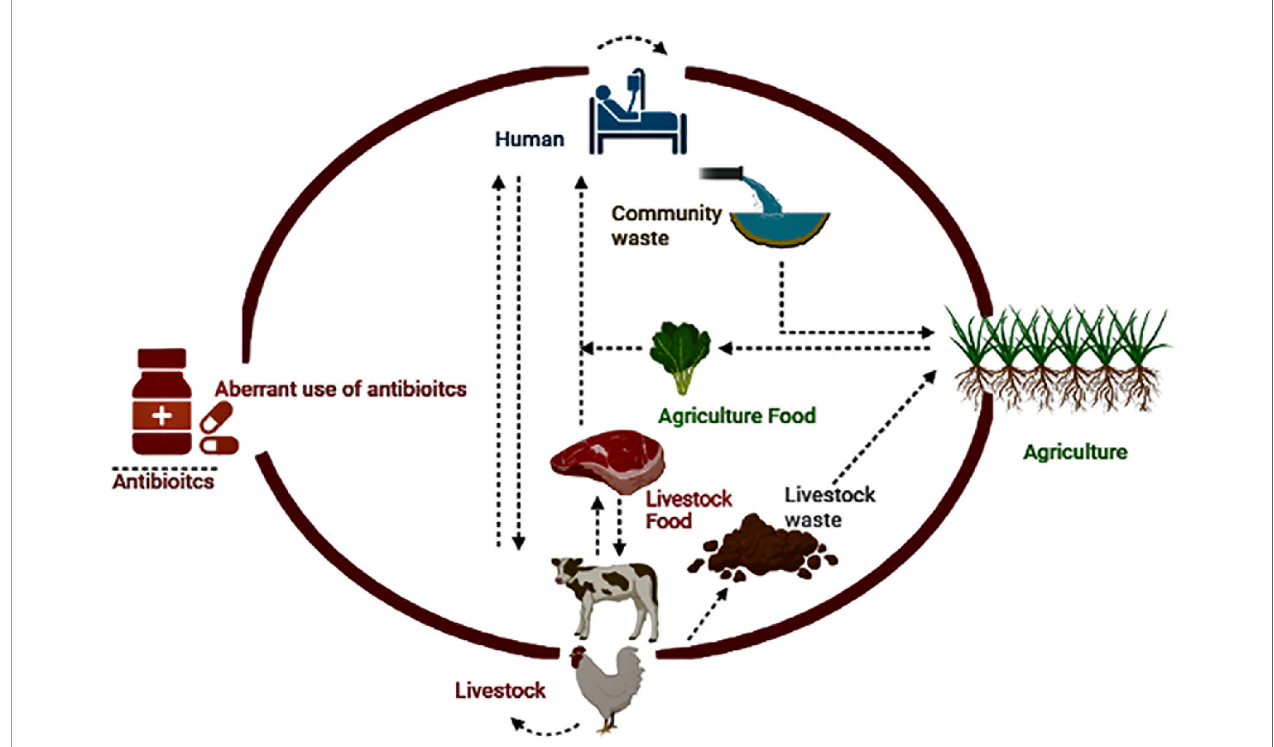
FIGURE 1 | Potential One Health drivers associated with